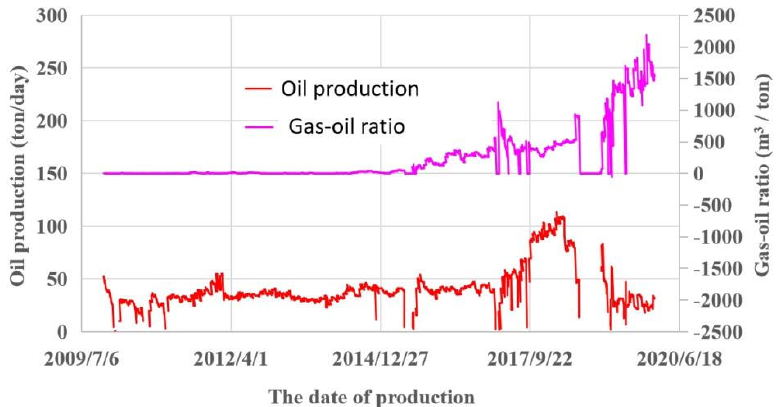
Figure 8. Production curve of oil production and gas ‐ oil ratio of a gas injection affected well D1.